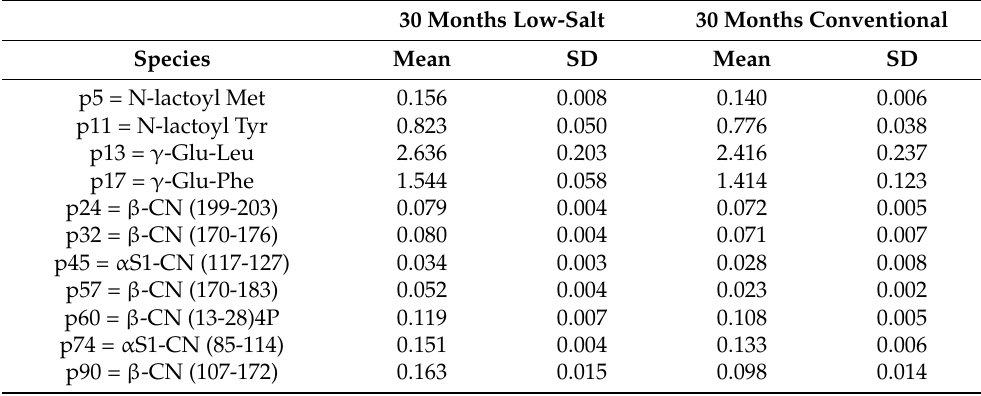
Table 4. Peptides with a significant difference between low-salt and conventional samples in 30-month-ripened cheese. Semiquantitative data, as normalized areas against the internal standard Phe-Phe, were considered as variables in statistical analysis and are expressed as the mean ± standard deviation over the samples of each group. Differences are significant at p < 0.05.